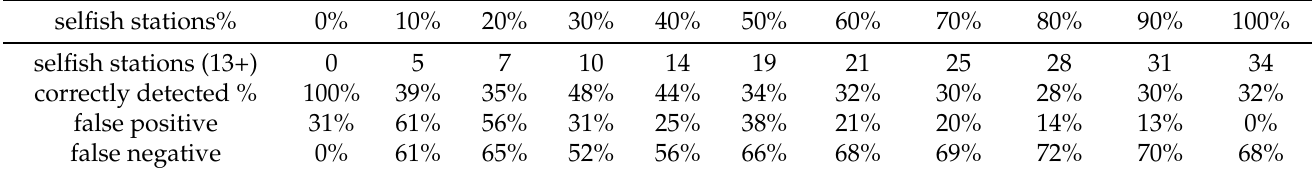
Table 9. ISSD detection for 50 stations with 2 slots in TCP firmware scenario.